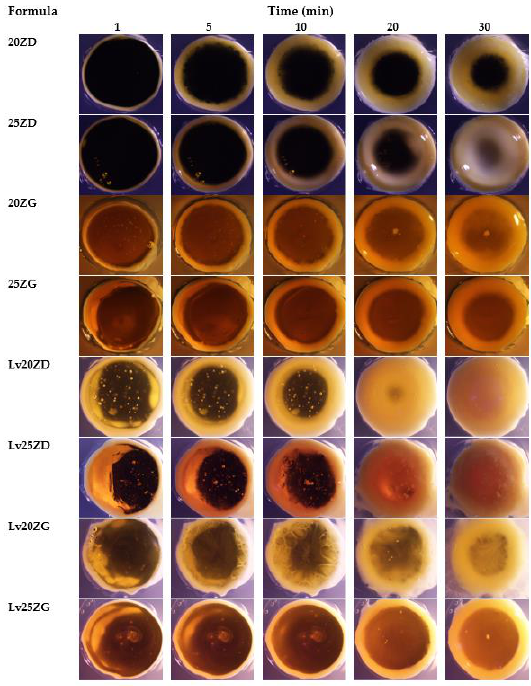
Figure 4. Gel formation of drug-free and Lv-loaded zein-based after contact with agarose gel with different time intervals under a stereomicroscope at a magnification of ×12. 3.4. Drug Content and In Vitro Drug Release Study The Lv content amount in the LvD, LvG, Lv20ZD, Lv25ZD, Lv20ZG, and Lv25ZG was 100.08 ± 0.74, 97.41 ± 0.16, 102.62.05 ± 0.82, 101.46 ± 0.88, 98.46 ± 0.82, and 99.11 ± 1.06, respectively. These formulations were prepared by a simple mixing process; thus, their amounts of Lv content were close to 100%. The drug-loaded zein ISGs were tested for their in vitro cumulative drug release using the cup method to mimic the surroundings of a periodontal pocket [28,29]. Various investigators have employed the cup method to un- dertake the drug release behavior of in situ forming drug delivery systems. Using this technique, doxycycline hyclate is released sustainably from ethyl cellulose, beta-cyclodex- trin, and poly(D,L-lactide-co-glycolide ISGs [55 – 57]. The control groups, such as LvD and LvG, released the drug completely at 28 h and 36 h, respectively, whereas the zein-based ISGs gradually released the Lv for 7 days into PBS pH 6.8 solution (Figure 5). The higher concentration zein loading resulted in more prolonged LV release in which the use of GF more retarded the drug liberation from ISG. The denser matrices from high-loading